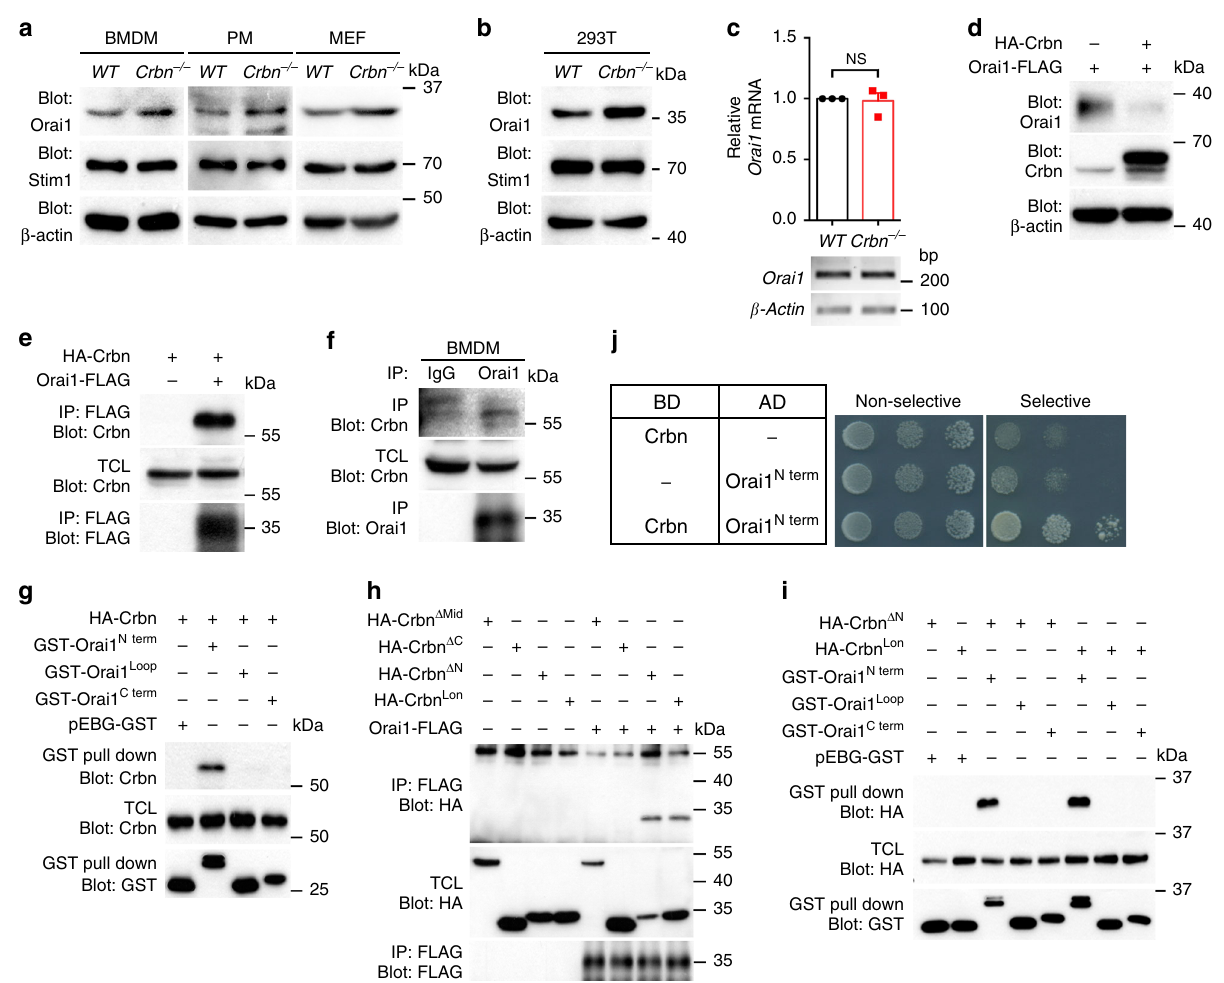
Fig. 4 Crbn interacts with Orai1. a , b Phagocytes from the indicated mice a or Crbn deleted 293T cells by CRISPR/Cas9 b were lysed and proteins in the lysates were detected using immunoblotting. Data are representative of three independent experiments. c The transcript levels of Orai1 were analyzed by conventional PCR (bottom) or qRT-PCR (top) using cDNA synthesized from total mRNA extracted from the indicated BMDMs. n = 3 experiments, mean ± SEM. NS not signi fi cant (two-tailed unpaired Student t test). d LR73 cells were transfected with the indicated plasmid. At 1 day after transfection, the cells were lysed and proteins in the lysates were detected with the indicated antibodies. Data are representative of three independent experiments. e , f 293T cells transfected with the indicated plasmids e or BMDMs f were lysed and then the lysates were incubated with anti-FLAG antibody-conjugated agarose beads e or an anti-Orai1 antibody and protein A/G agarose beads f . Bead-bound proteins were detected with the indicated antibodies. Data are representative of fi ve e or three f independent experiments. IP immunoprecipitation, TCL total cell lysates. g – i 293T cells were transfected with the indicated plasmids. At 2 days after transfection, the cells were lysed and the lysates were incubated with agarose beads conjugated with glutathione g , i or an anti-FLAG antibody h . Bead-bound proteins were detected with the indicated antibodies. Data are representative of four g or three h , i independent experiments. j Yeast cells transformed with the indicated plasmids were plated on selective or non-selective media. Cells on the non-selective media indicate the number of cells plated. BD binding domain, AD activation